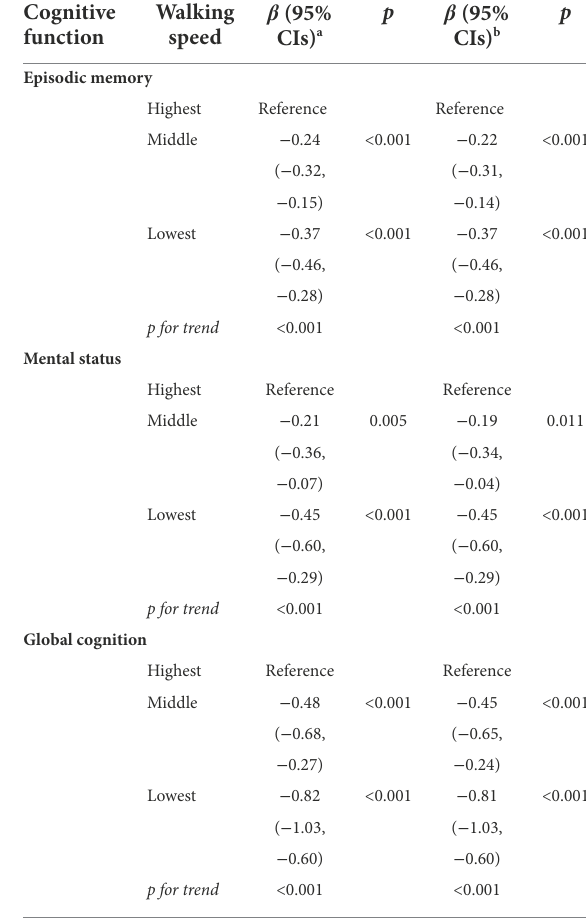
TABLE 2 The association between walking speed and subsequent cognitive function in the CHARLS. Cognitive